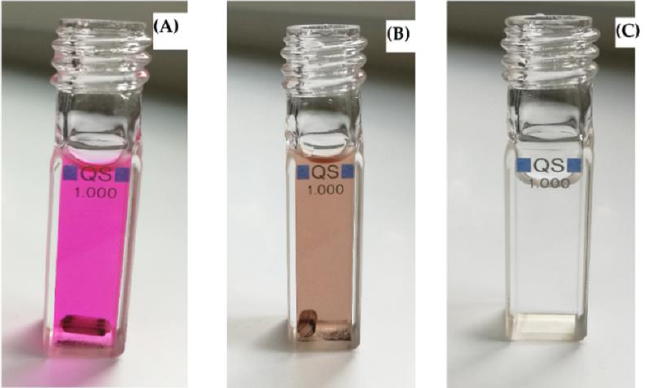
Figure 13. Visual representation of RhB degradation in photo-Fenton process in the photo-reactor (cuvette). ( A ) Mixture of RhB + NP-3 before photocatalysis, ( B ) RhB + NP-3 after photocatalysis, and ( C ) clear solution obtained after separation of solid catalyst from ( B ).